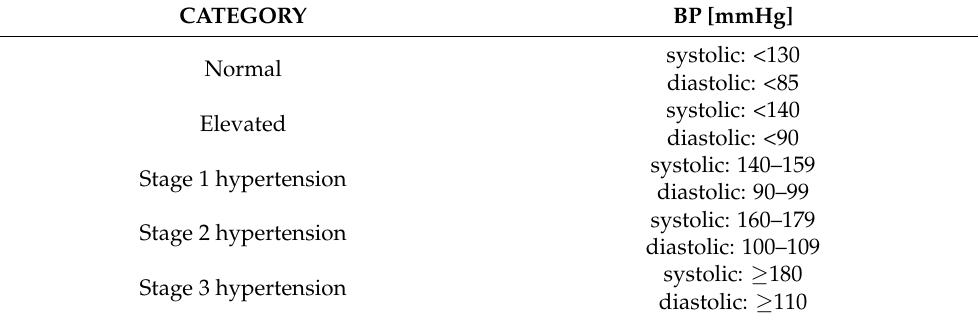
Table 1. Categories of BP [4].